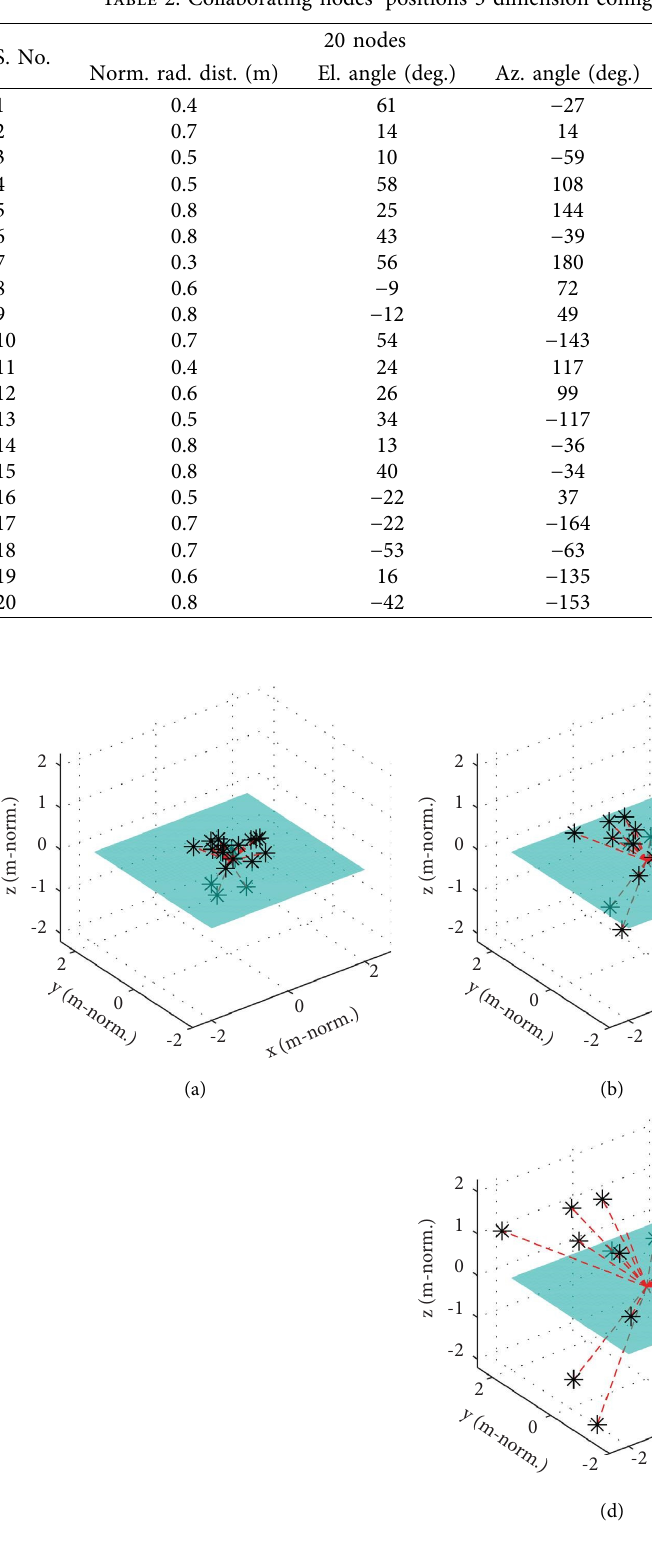
Figure 4: 3-dimension cluster arrangements featuring cluster radii 1, 2, 3, and 4 (identical node distribution patterns have been utilized to allow for a fair